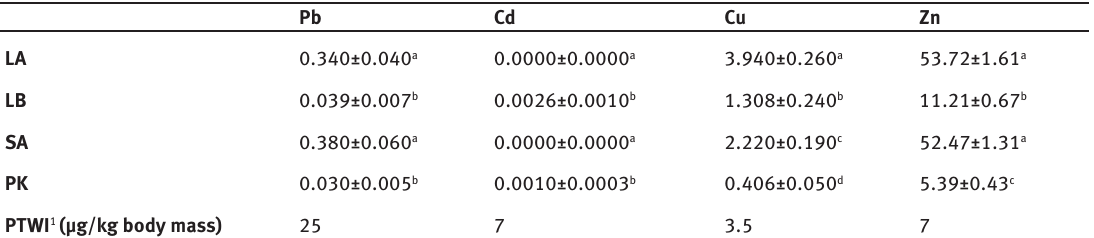
Table 8: Content of lead, cadmium, copper and zinc [mg/kg product] in cottage cheese from various regions of Poland. Pb